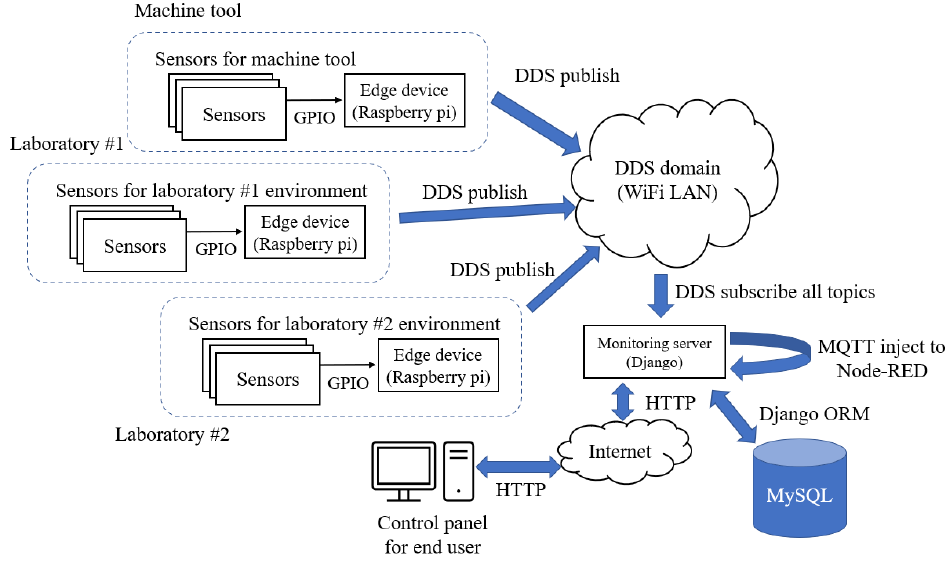
Figure 5. Architecture of the proposed cloud platform.